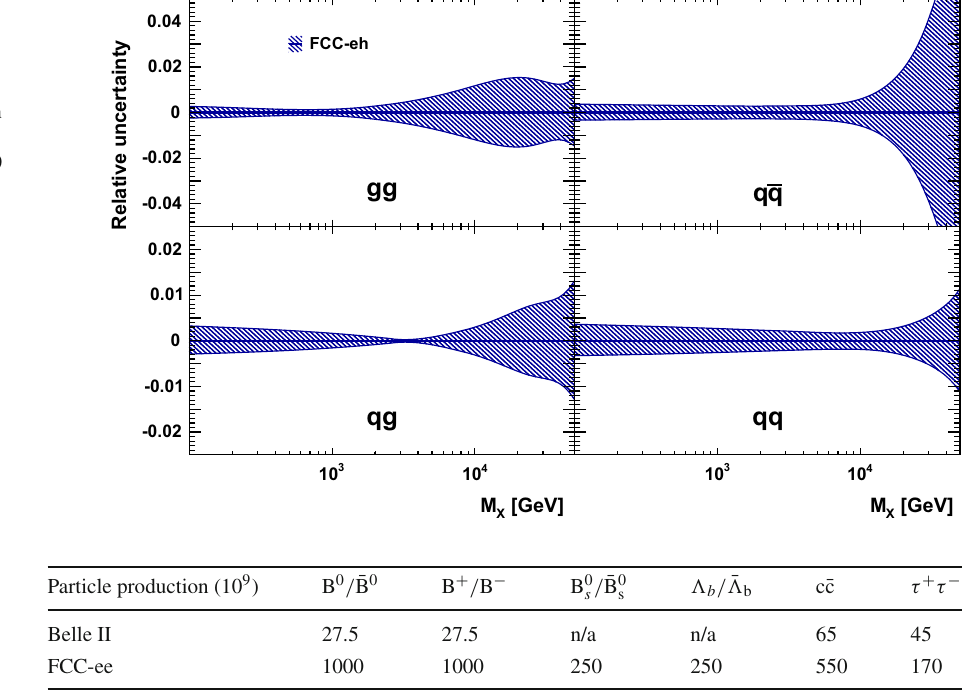
Table S.4 Expected production yields for b-flavoured particles at FCC-ee at the Z run, and at Belle II (50ab − 1 ) for